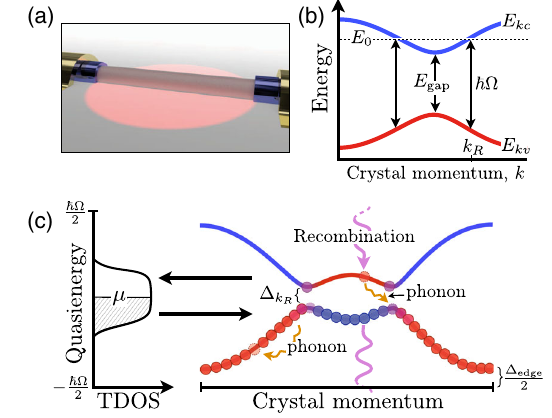
FIG. 1. Carrier kinetics in a Floquet-Bloch system coupled to Bose and Fermi reservoirs. (a) One-dimensional semiconductor wire coupled to an energy-filtered fermionic reservoir. Energy filtering is achieved by coupling the system and reservoir via a deep impurity band in a semiconductor with a large band gap. (b) Band structure of the nondriven system. The driving-field photon energy ℏ Ω exceeds the band gap E , causing resonant gap coupling at crystal momentum values (cid:1) k . (c) Floquet band R structure, indicating the character of the Floquet band in terms of the original conduction (blue) and valence (red) bands. Coupling to acoustic phonons mediates electronic momentum and energy relaxation (orange arrows), while radiative recombination scatters electrons vertically between conduction- and valence-band-like states (purple arrow). At half filling, the steady state resembles that of an insulator with a small density of excited electrons and holes. Coupling to an energy-filtered Fermi reservoir (depicted on the left) can further suppress the density of